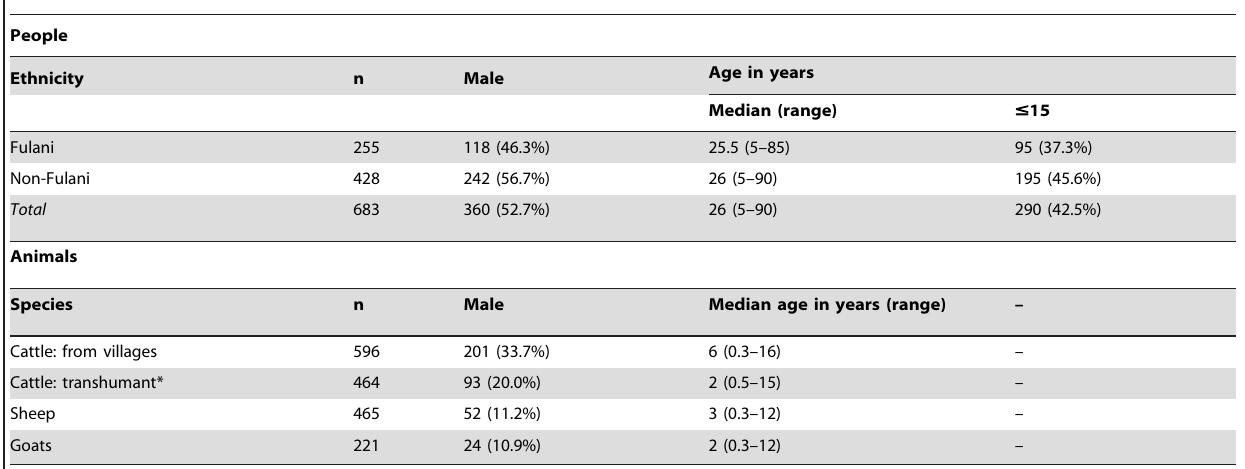
Table 1. Characteristics of study participants from 25 villages in northern Togo.